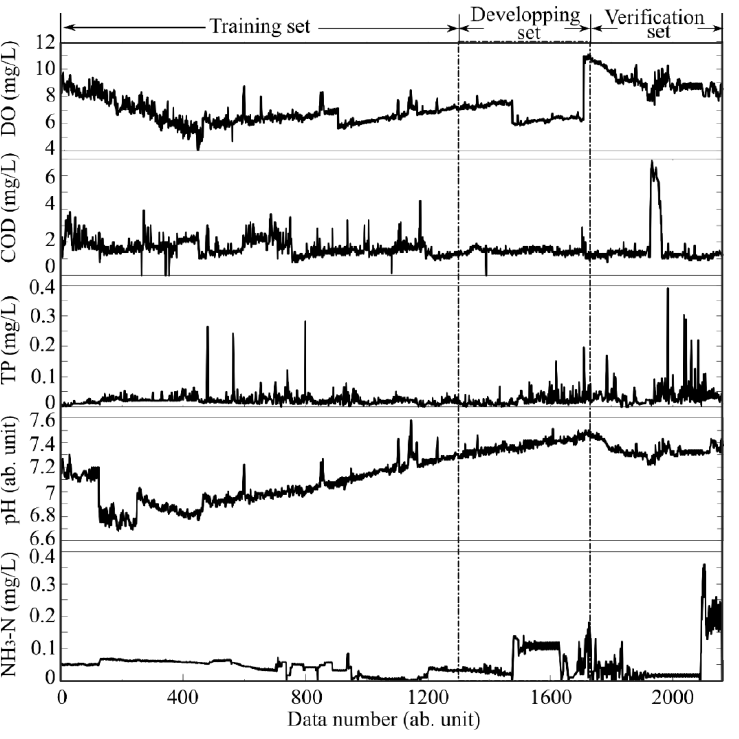
Figure 4. Preprocessed original data of water quality parameters.